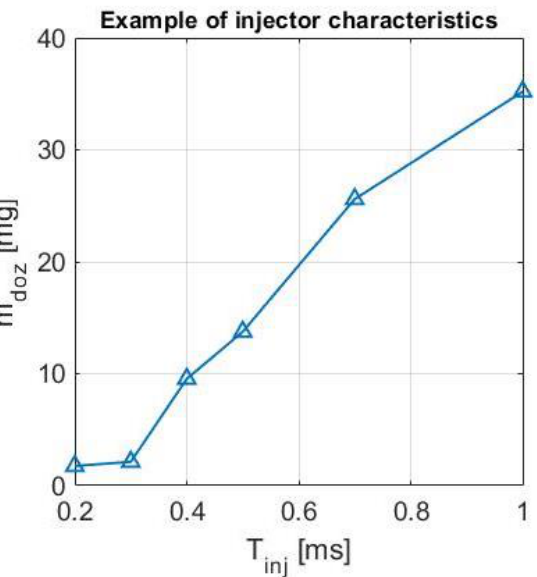
Figure 1. Example of injector characteristics. The lower slope before 0.3 ms is the result of the ballistic injection.